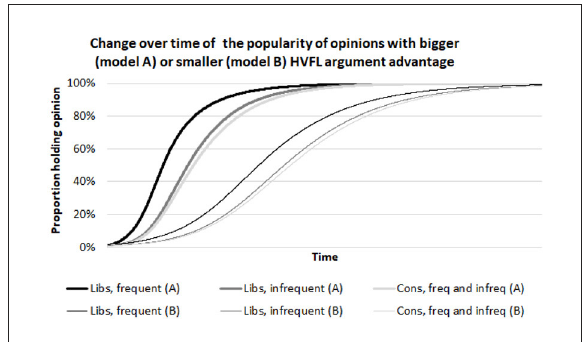
FIGURE1 Typical runs of the computational model differing only in the HVFL argument advantage set to be bigger in Model A and smaller in Model B. On the x-axis is time, on the y-axis is the popularity of an opinion with HVFL argument advantage. For details, see the Supplementary